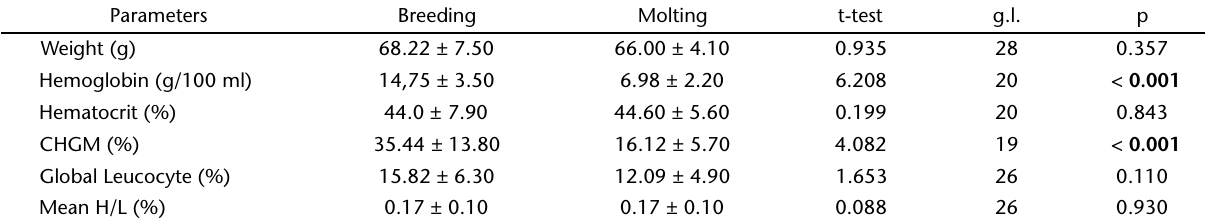
Table I. T-test for the biological parameters (weight) and hematological (mean ± SD) of T. leucomelas in Parque Estadual Rio Preto, at breeding season and molt season.